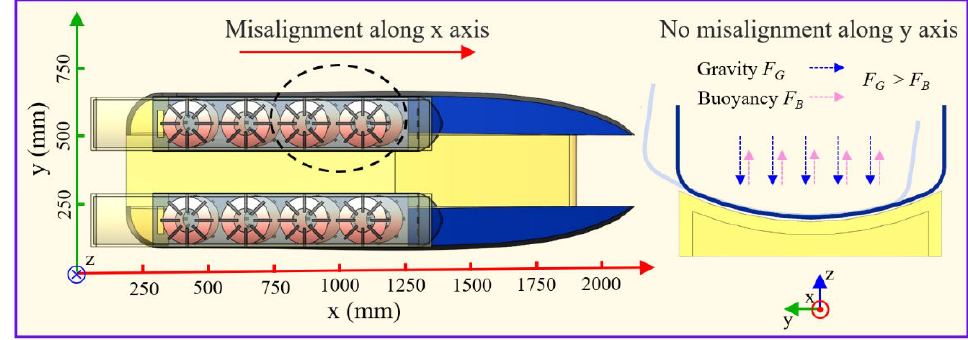
Figure 2. Working principle of Rx limiter.